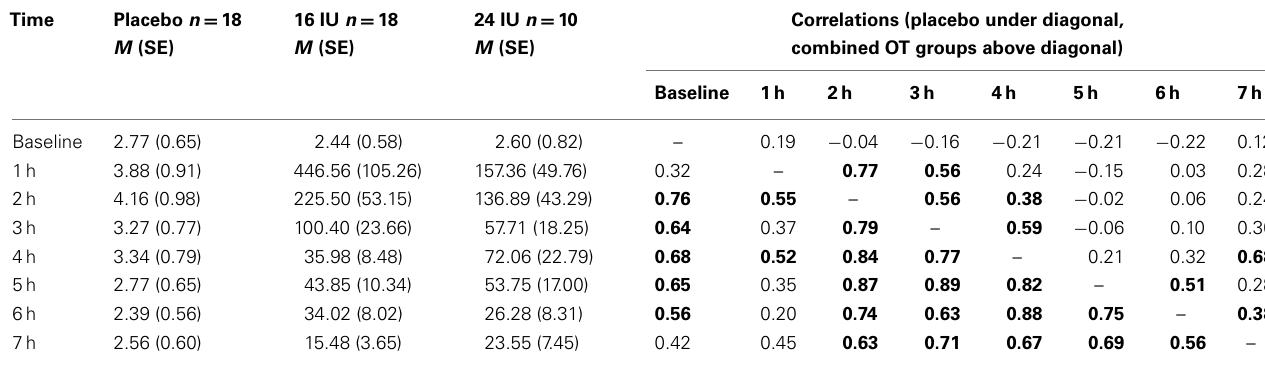
Table 1 | Salivary oxytocin levels (M, SE) up to 7h after intranasal administration and stability of OT levels over the day.